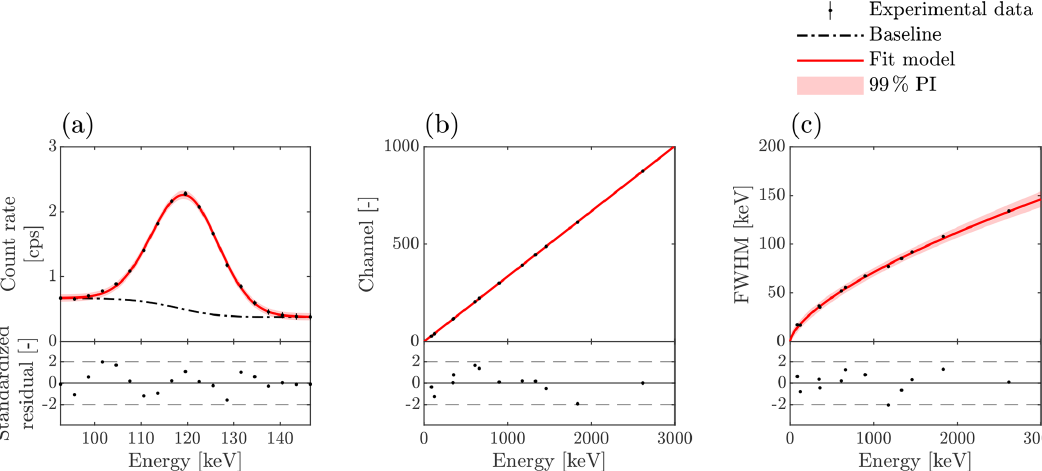
Figure 2. Spectral postprocessing of the experimental data for the scintillation crystal 3. (a) Experimental net spectrum of the 152 Eu source showing the full energy peak at 121.7817(3)keV together with the resulting peak fit and baseline model. (b) Energy calibration model using peak fit data from various radiation sources, i. e. 60 Co, 88 Y, 109 Cd, 137 Cs, 152 Eu, K nat , Th nat and U nat . (c) Experimental resolution model characterizing the full width at half maximum (FWHM) and adopting the same peak fit data from radiation sources as for the energy calibration model. The prediction interval (PI) is computed for a significance level of 1% for all statistical models. Experimental error bars are defined as 1SD (only visible in Fig.